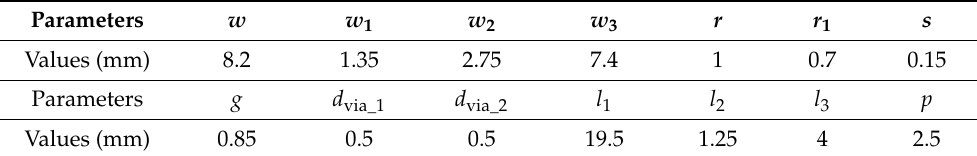
Table 1. Parameters of BPF Using the Proposed SSPP.